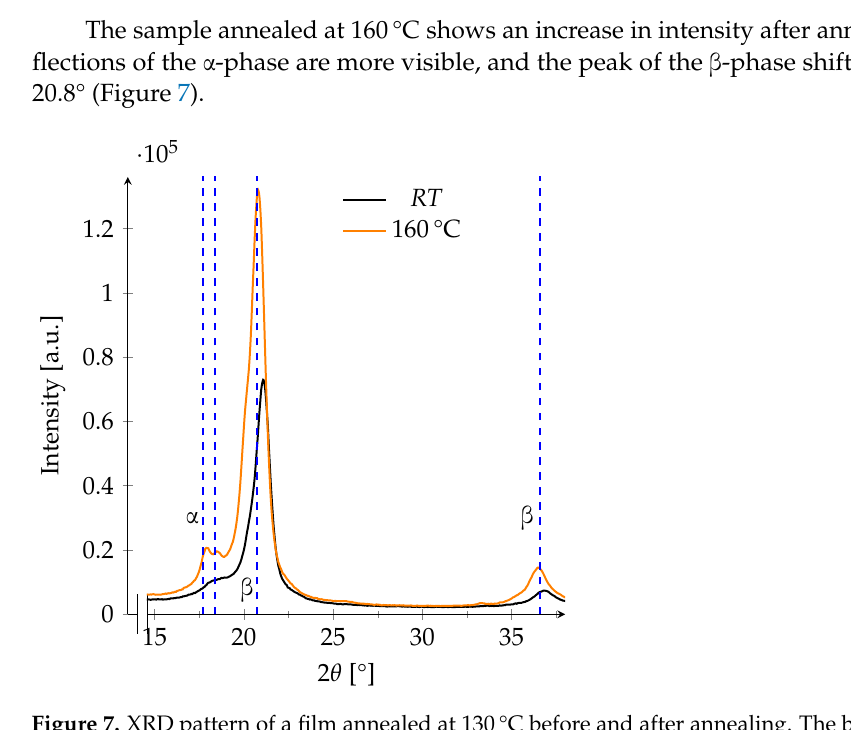
Figure 7. XRD pattern of a film annealed at 130°C before and after annealing. The blue dashed lines at 17.7° and 18.4° refer to the expected main reflections of the α -phase, and the lines at 20.75° and 36.6° refer to those of the β